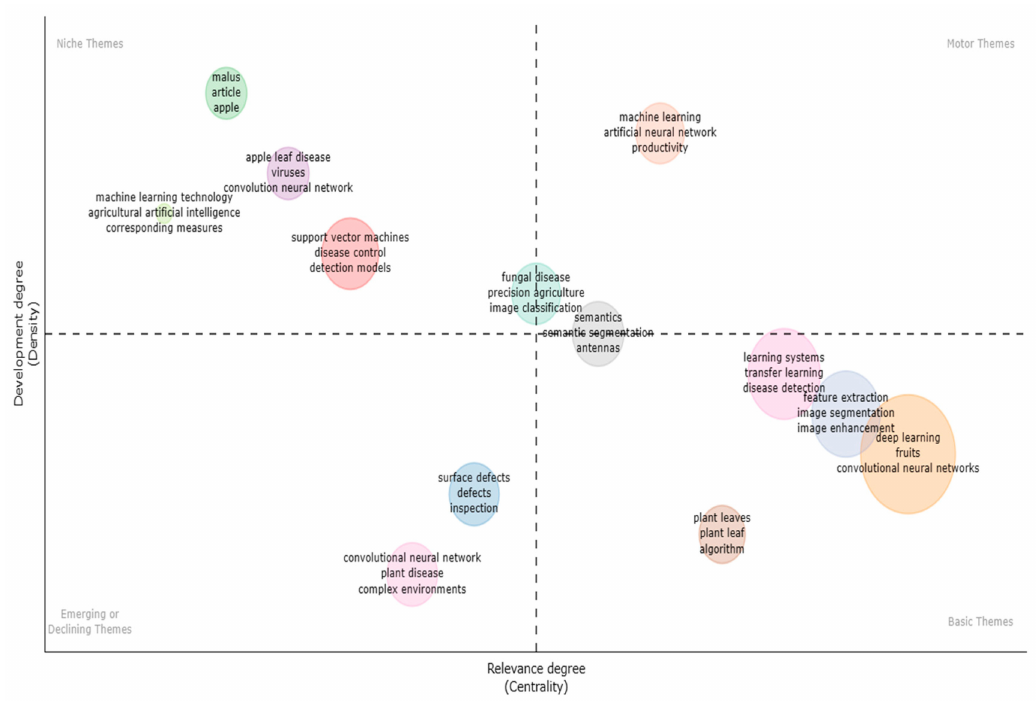
Figure 23. Thematic Map (Source: Author elaboration using